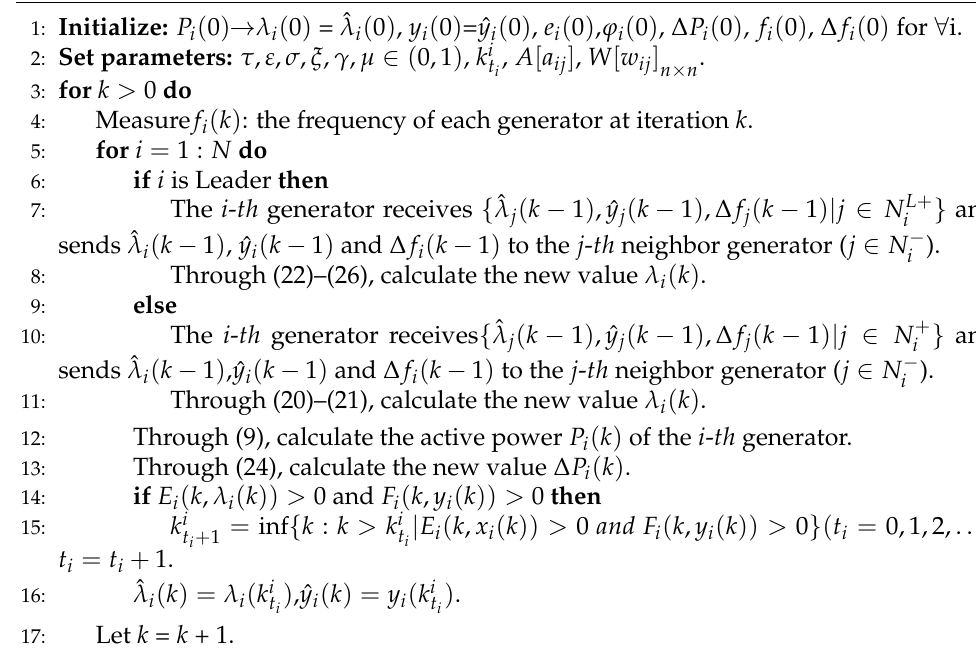
Algorithm 2 Event-triggered based DED approach